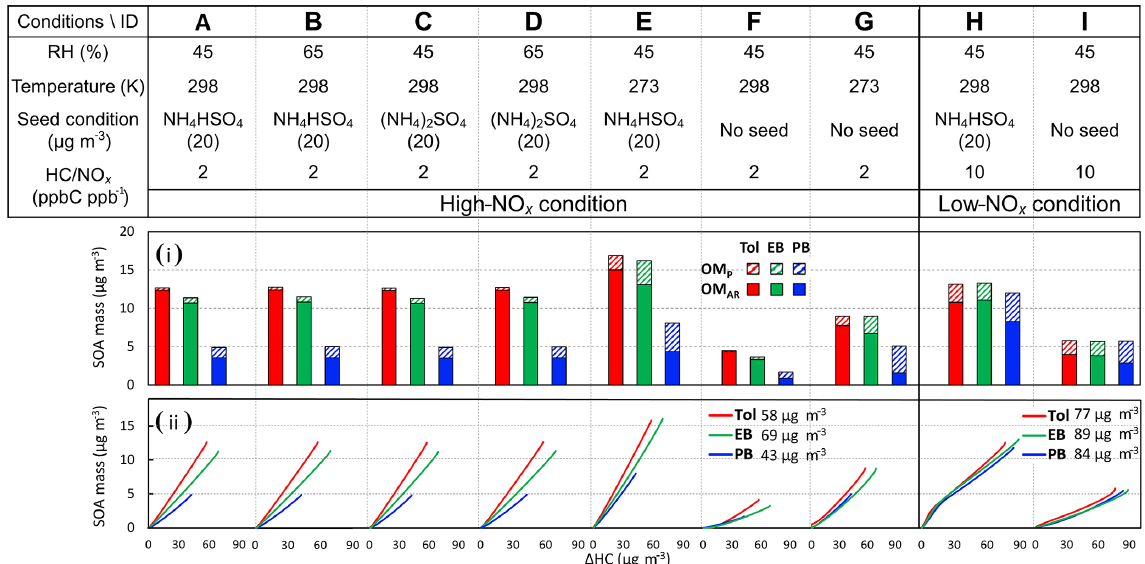
Figure 7. The simulated SOA mass (i) for toluene (Tol), ethylbenzene (EB), and n -propylbenzene (PB) under different conditions. The simulation conditions are listed in the top table. The initial concentrations of monoalkylbenzenes, preexisting OM (OM 0 ), NH 4 HSO 4 (AHS)- seeded aerosol, and (NH 4 ) 2 SO 4 (AS)-seeded aerosol are 20ppb, 2, 20, and 20µgm − 3 , respectively. The gas-phase simulation used the sunlight on 14 June 2018 (Exp. Tol9 in Table 1). OM P (diagonal stripes fill) and OM AR (solid fill) represent the organic matter from the partitioning process and aerosol-phase reactions. (ii) shows the time-dependent SOA growth curve for three monoalkylbenzenes under corresponding simulation conditions (top table). The concentrations that follow the legends refer to the mass concentrations of the consumed monoalkyl-substituted benzenes in each simulation under the high or low-NO x